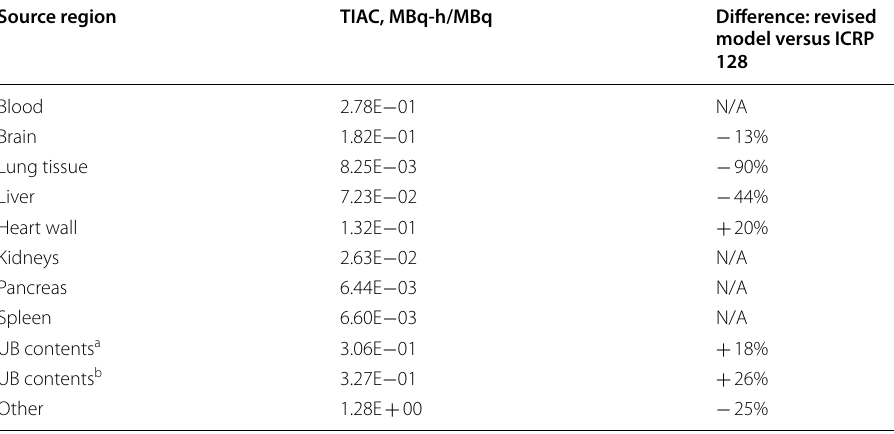
a For adult male b For adult